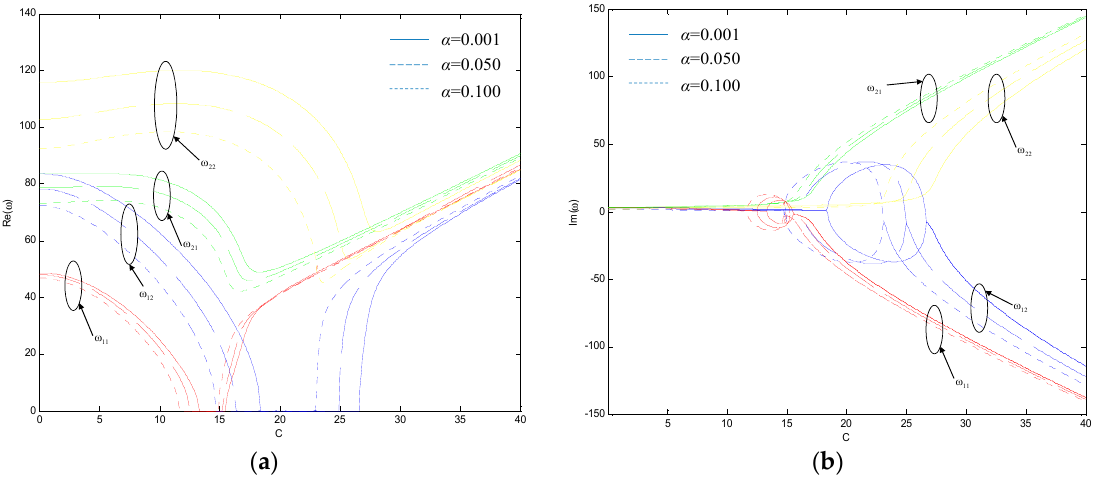
Figure 10. Effect of the small-parameter α on dimensionless complex frequencies of the axially-moving nanoplate resting on a viscoelastic foundation.